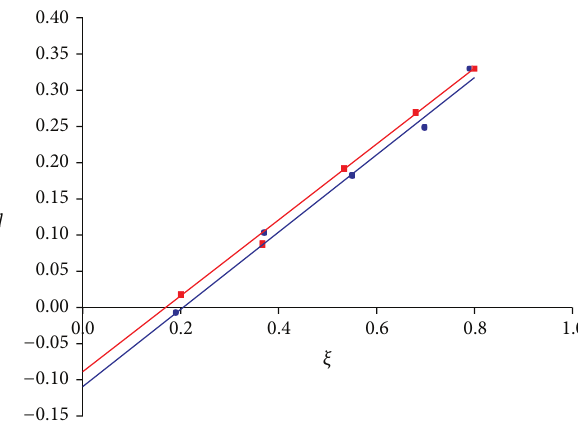
Figure 1: KT plots for the copolymerization of NTBA-MA using ◼ 1 H NMR and ∙ elemental analysis data. Slope = 𝑟 intercept −𝑟 2 /𝛼